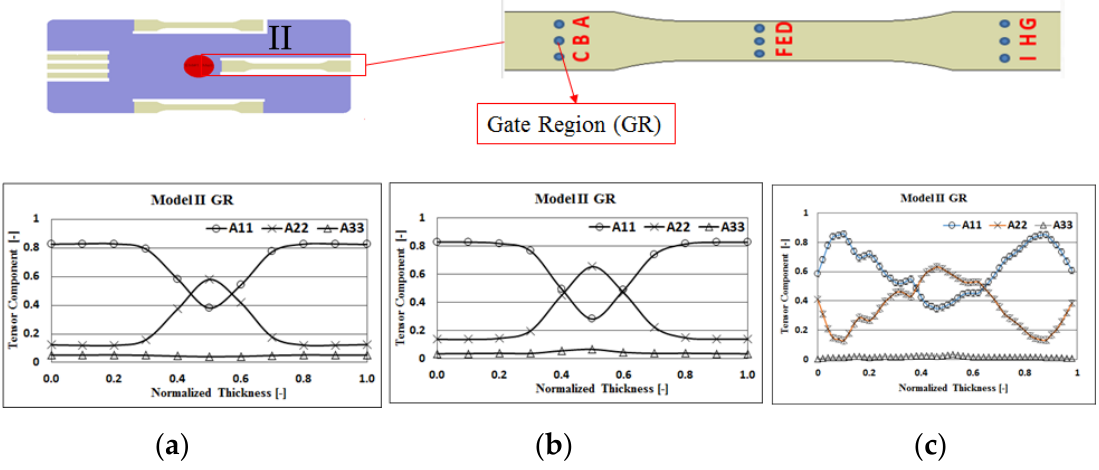
Figure 10. The comparison of the fiber orientation tensor components for Model II at Point B at GR: ( a ) simulation without flow–fiber coupling, ( b ) simulation with flow–fiber coupling, ( c ) experimental observation.